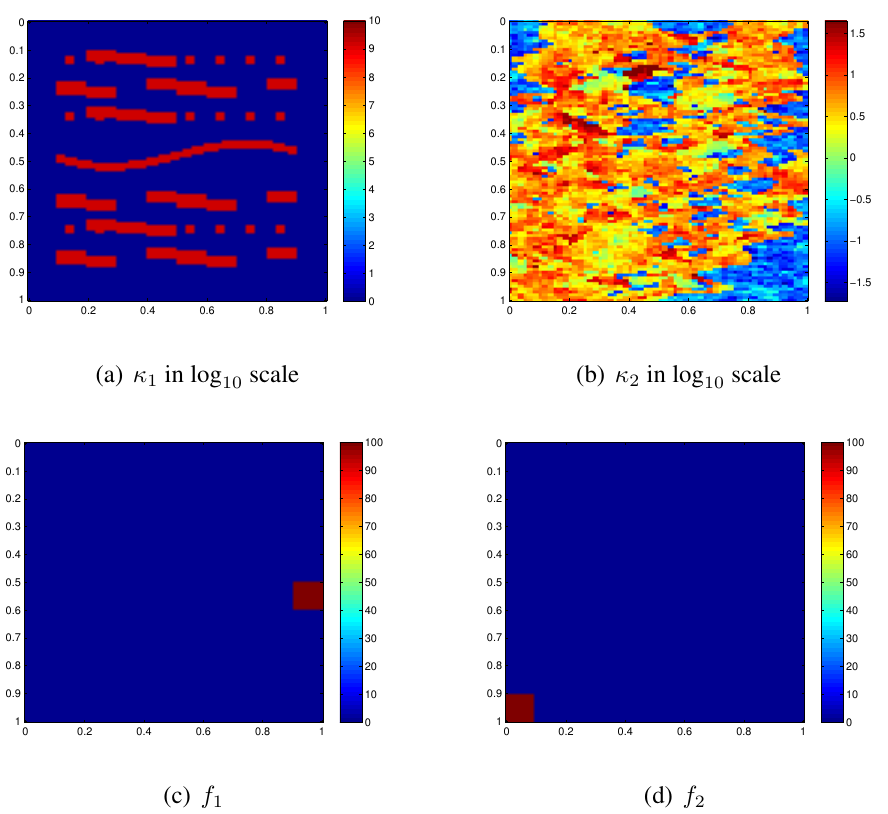
Figure 3. Two permeability fields ( a,b ) and two source terms ( c,d